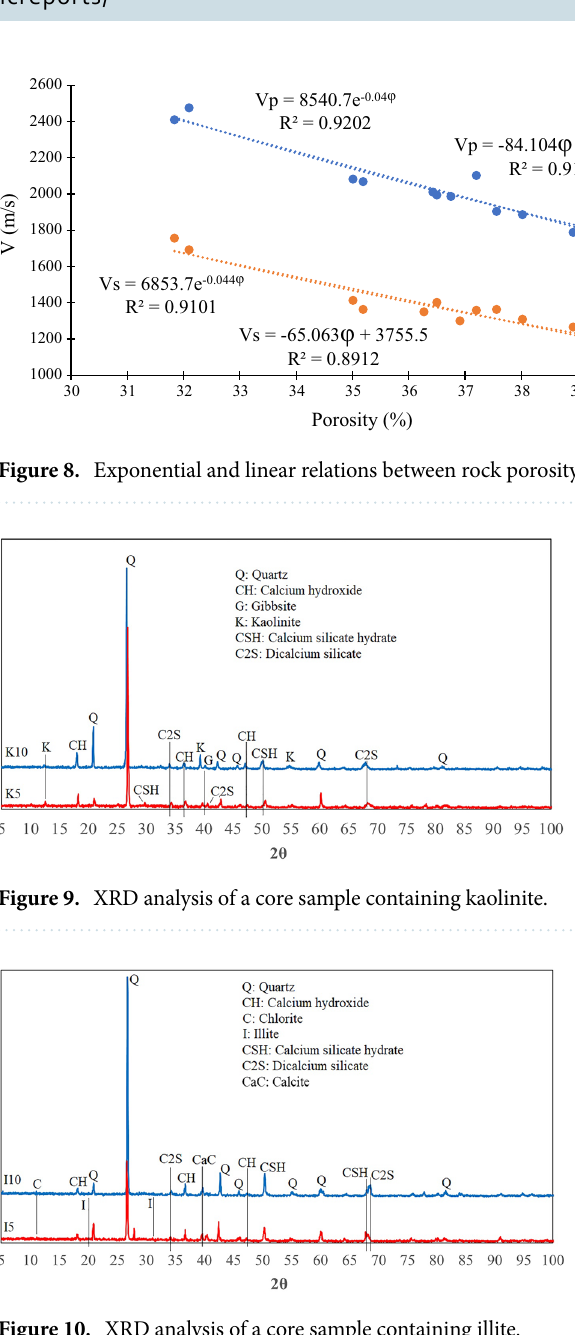
Figure 10. XRD analysis of a core sample containing illite.